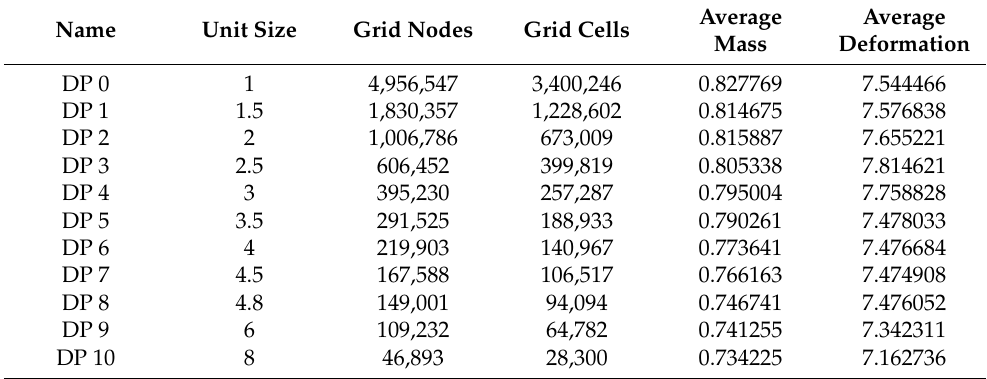
Table 2. Grid independence test.